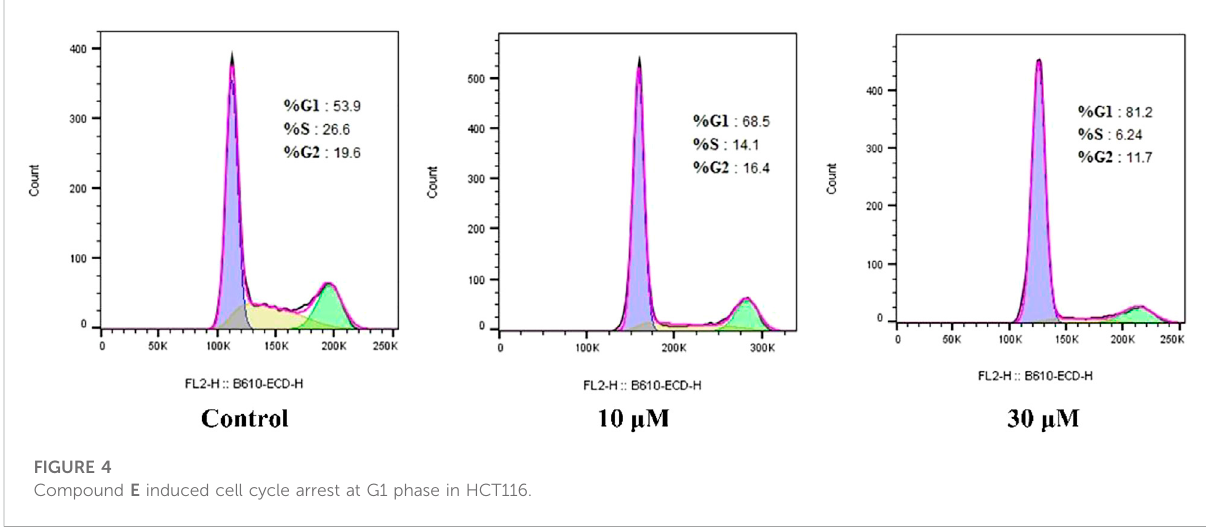
FIGURE 4 Compound E induced cell cycle arrest at G1 phase in